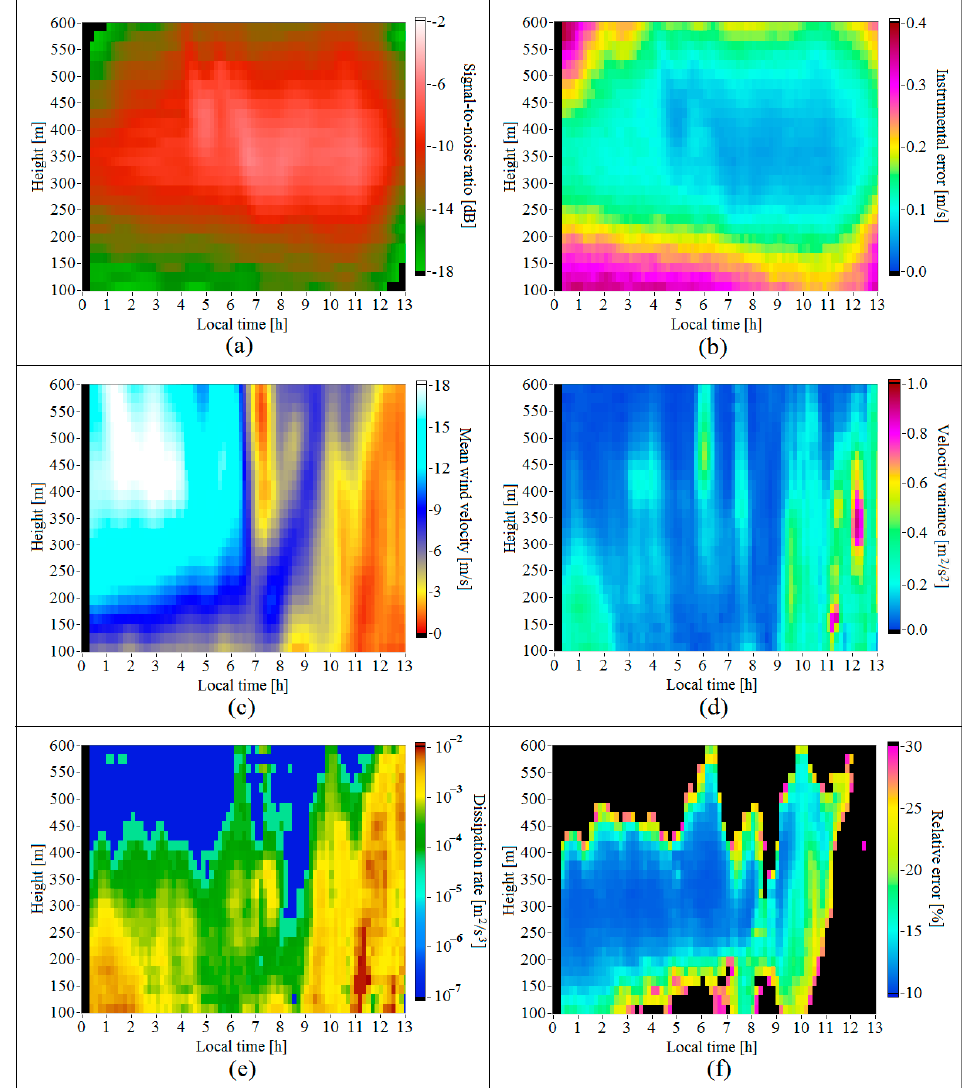
Figure 8. Height–temporal distributions of the signal-to-noise ratio ( a ), instrumental error of estimation of the radial velocity ( b ), mean wind velocity ( c ), variance of the vertical component of wind velocity vector ( d ), turbulent energy dissipation rate ( e ), and relative error of lidar estimation of the dissipation rate ( f ). Data obtained on 2 July 2020.